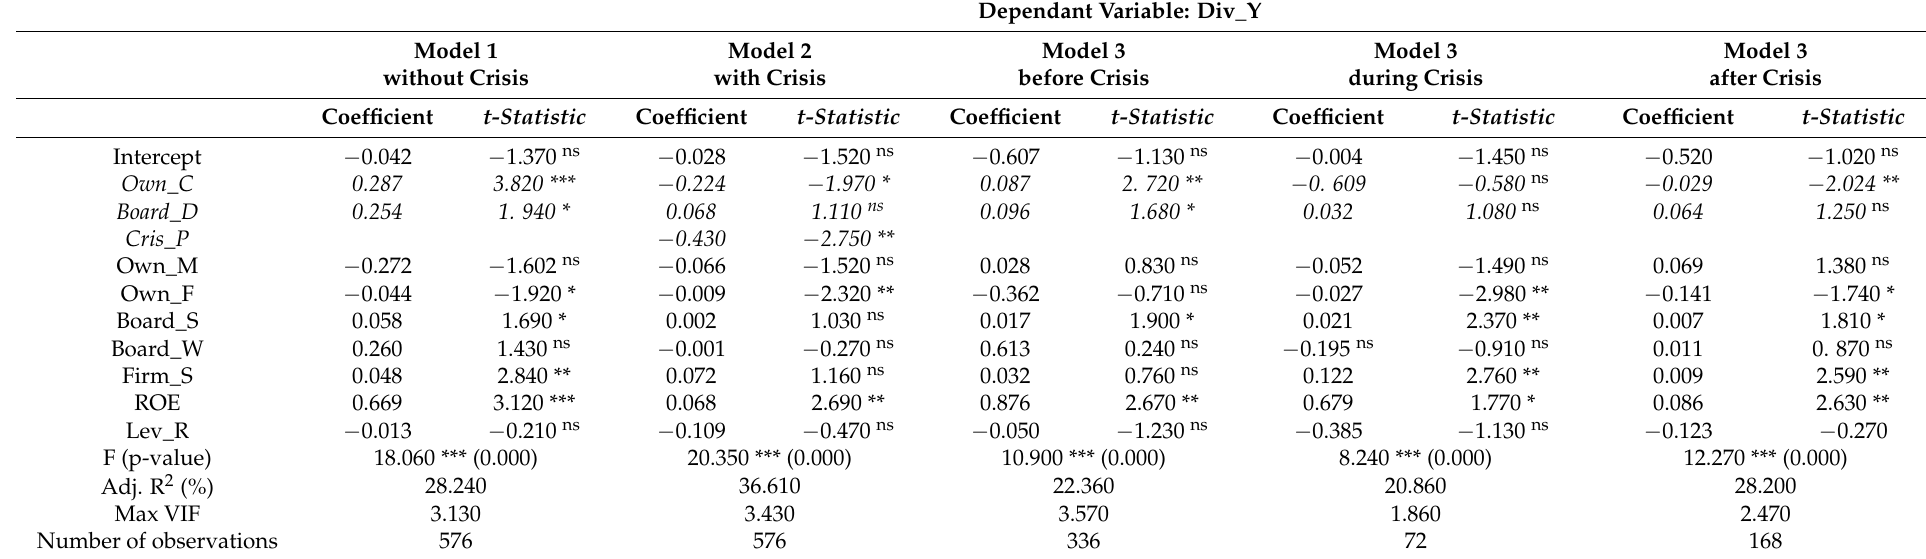
Table 5. Multivariate regression